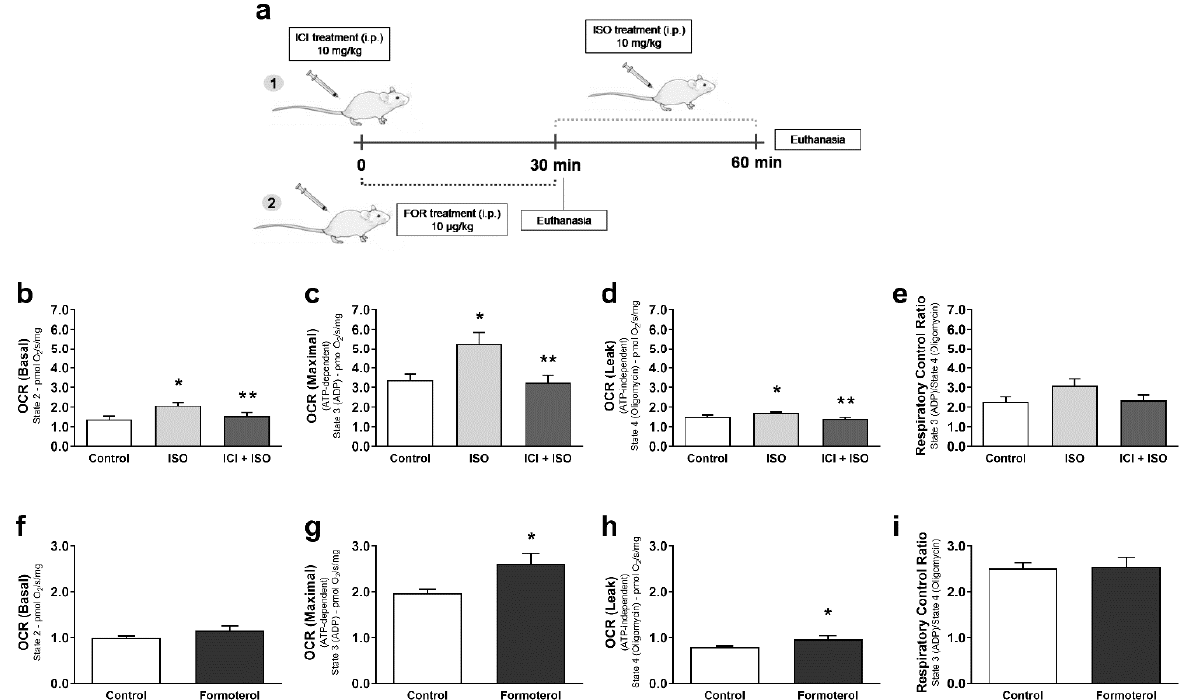
Figure 4. Pharmacological activation of β 2 -AR receptors leads to increased mitochondrial respiration in skeletal muscle. Experimental design for pharmacological treatments in mice ( a ), basal mitochondrial OCR (oxygen consumption ratio) ( b ), maximal mitochondrial OCR induced by ADP ( c ), ATP-independent OCR measured in the presence of oligomycin ( d ), and the respiratory control ratio ( e ) in permeabilized fiber bundles of tibialis anterior muscle isolated from mice treated with the non-selective β -AR agonist isoproterenol (ISO—single dose—10 mg/kg, i.p. 30 min), with or without β 2 -AR receptor blockade with ICI 118,551 (single dose—10 mg/kg, i.p., 30 min prior to ISO treatment). Basal mitochondrial OCR ( f ), maximal mitochondrial OCR induced by ADP ( g ), ATP-independent OCR measured in the presence of oligomycin ( h ), and the respiratory control ratio ( i ) in permeabilized fiber bundles of tibialis anterior muscle isolated from mice treated with the selective β 2 -AR agonist formoterol (FOR-single dose—10 µg/kg, i.p., 30 min). Data are presented as mean ± SE. * p < 0.05 vs. control and ** p < 0.05 vs. ISO. n = 5/group.